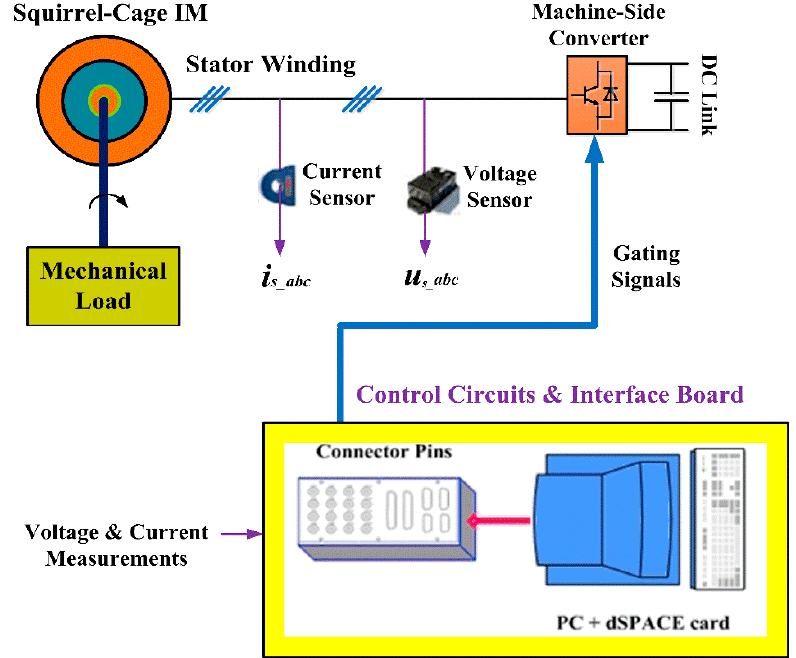
Figure 20. Conceptual diagram of the adopted sensorless control system.